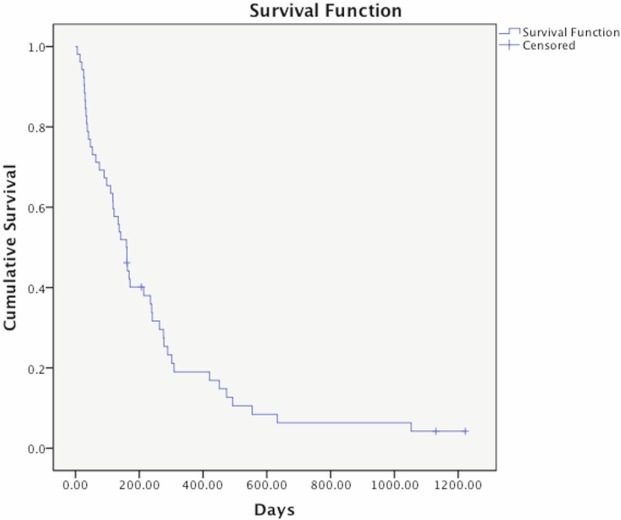
Kaplan–Meier survival curve of 52 patients receiving palliative radiotherapy. The overall median survival of these patients was 160 days (95% CI 119–201 days). Four patients were alive and censored at the time of analysis.